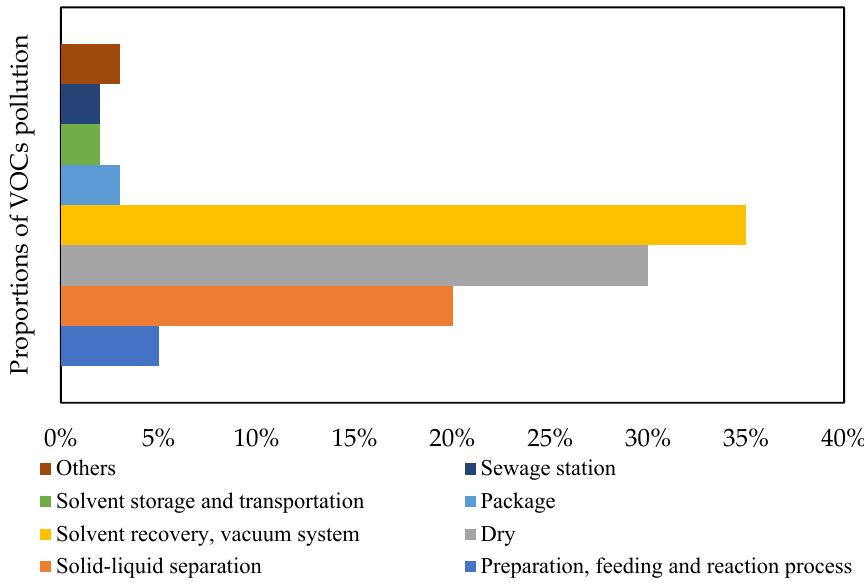
Figure 3. Nodes and proportions of VOC pollution in the pesticide industry. (Others: hazardous waste temporary storage, dynamic and static equipment sealing, process sampling, circulating water system).